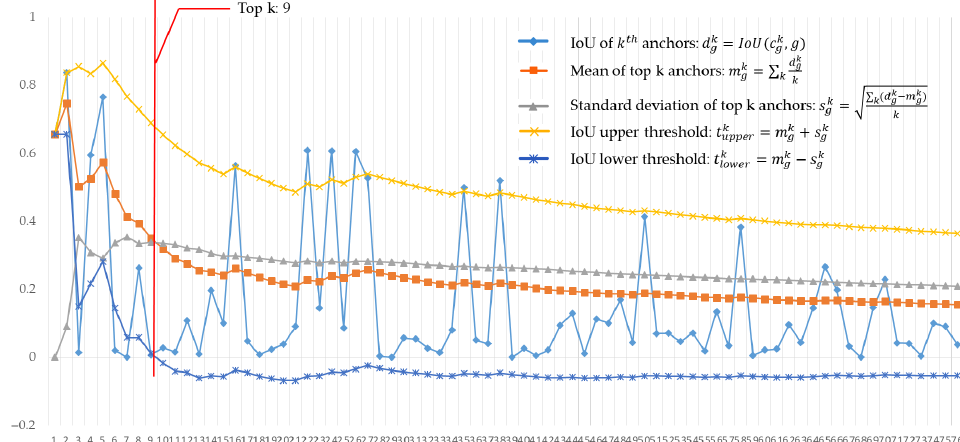
Figure 4. The hyper-parameter k ’s curve with the mean and standard deviation of the top k candidates.